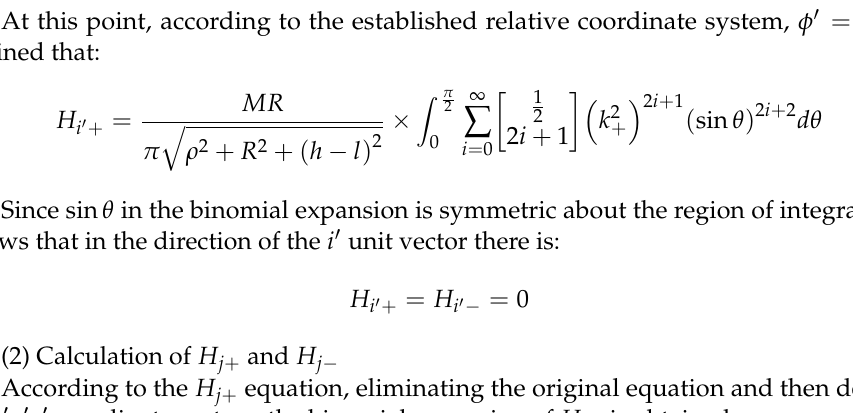
Figure 5. Schematic diagram of relative coordinate system 𝑥 ′ 𝑦 ′ 𝑧 ′ .